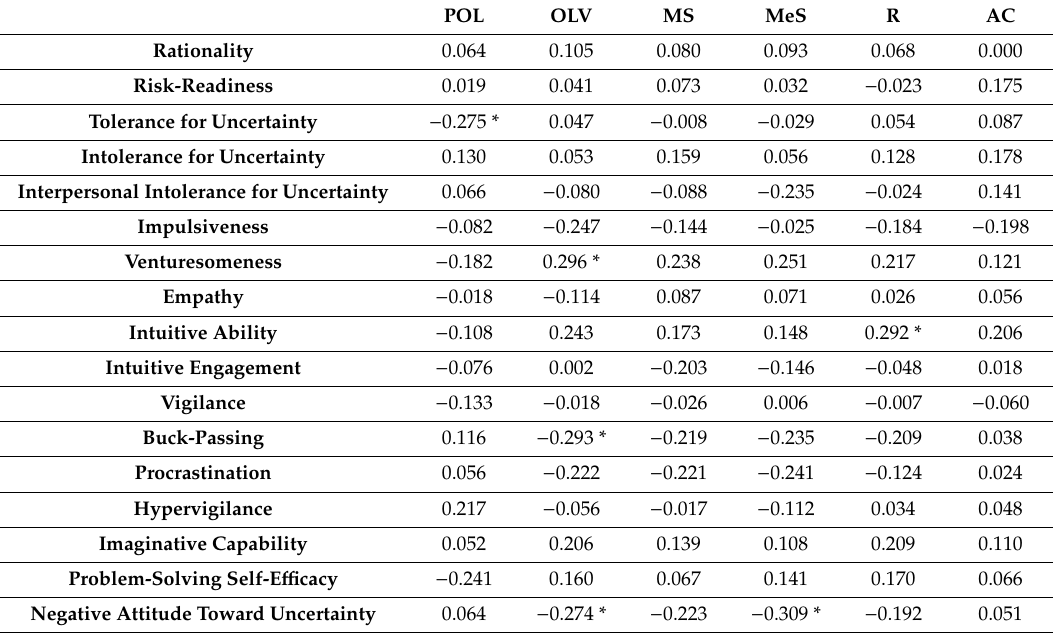
Table A5. Correlations between psychodiagnostics questionnaires scales and complex problem-solving strategies‘ parameters. POL OLV MS